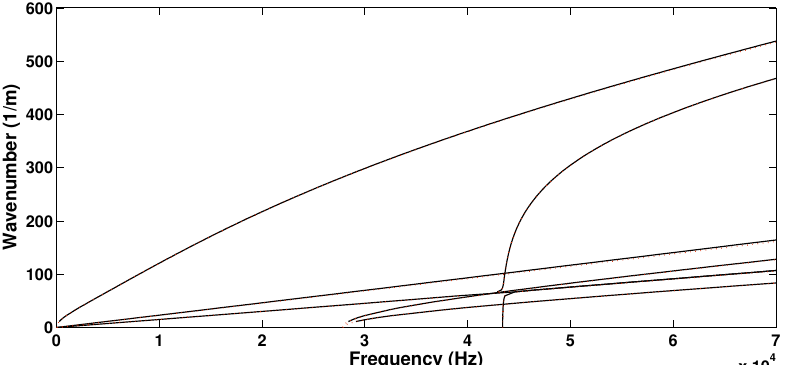
Figure 5. The real part of the wavenumbers propagating at a direction of 45 ◦ within the sandwich panel having a piezoelectric patch attached to it: patch with no piezoelectric coupling (–), piezoelectric patch (-